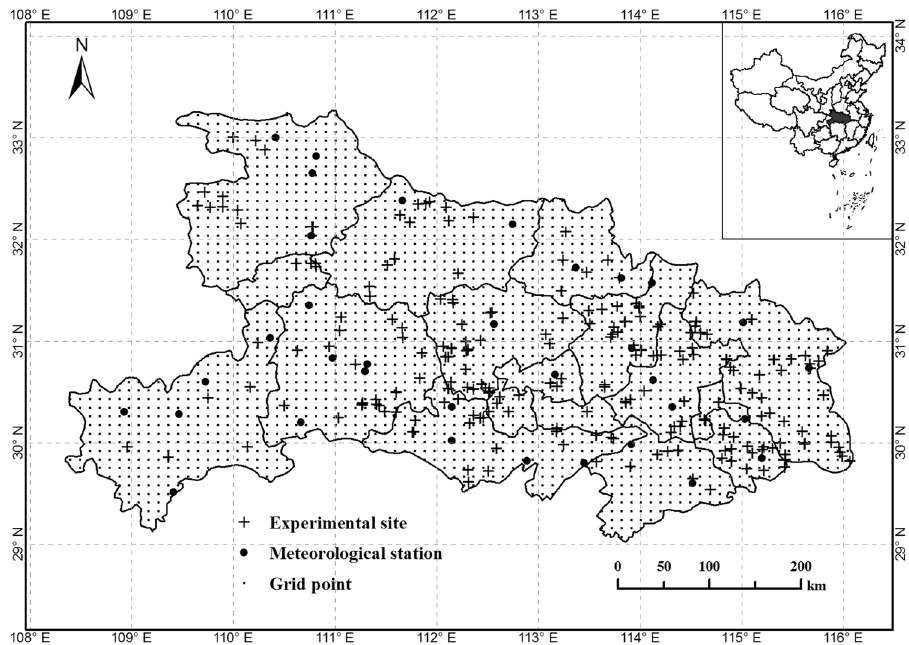
Figure 6. Distribution of meteorological stations, experimental sites and grid points for winter oilseed rape in Hubei province. Figure was created by ArcGIS Desktop (Version 9.3, URL: http://www.esri.com)